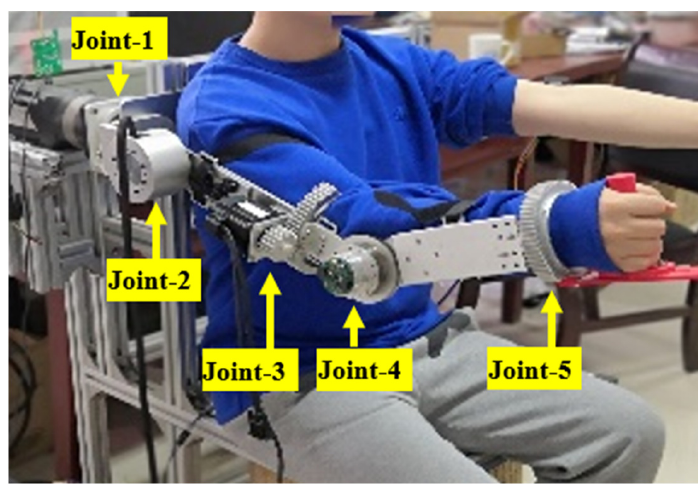
Figure 7. Prototype device of the upper-limb exoskeleton manipulator. Table 2. Exoskeleton joint range of motion.